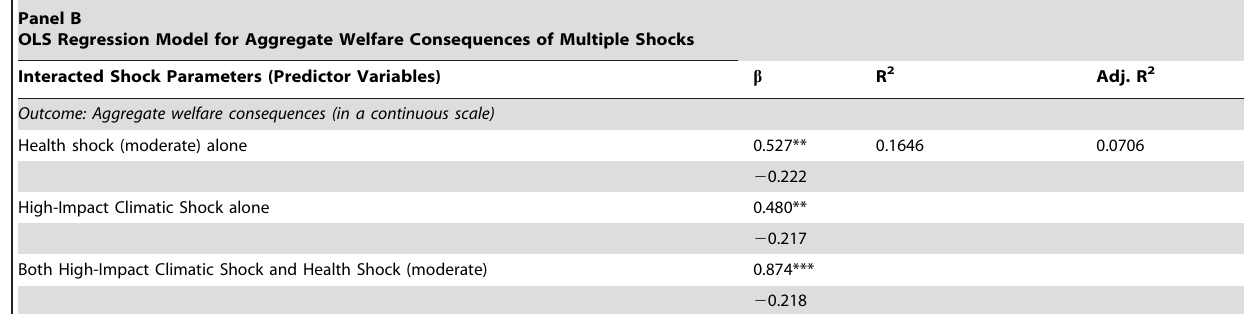
Panel C Poisson Regression Models for Count of Adverse Welfare Outcomes